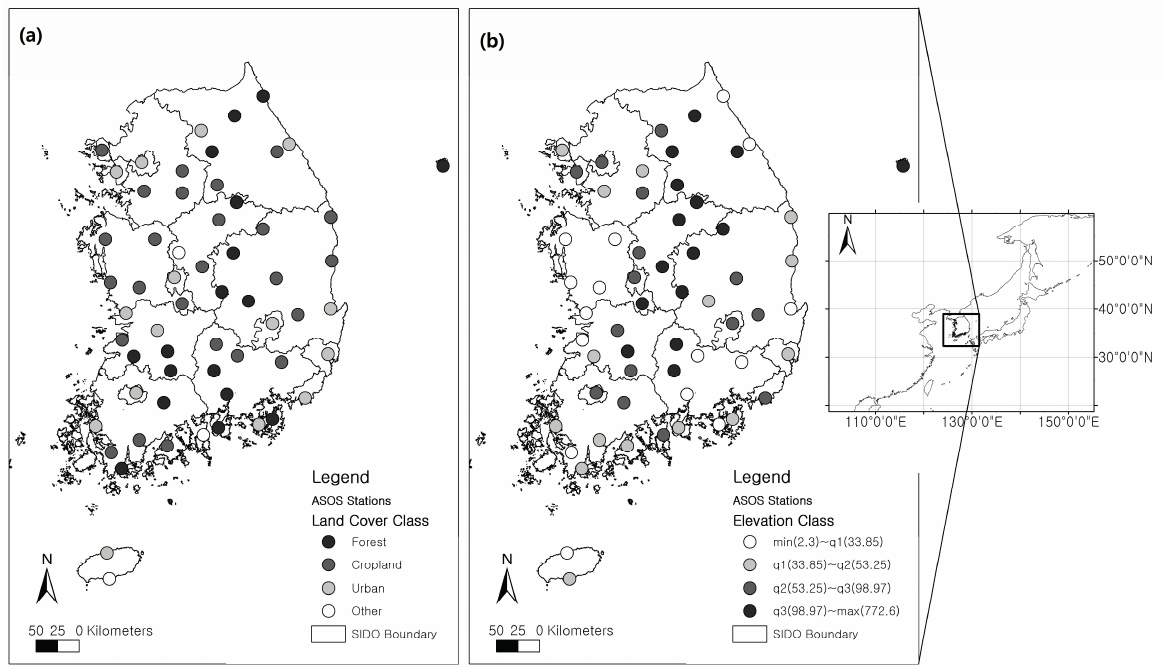
Figure 1. Sixty ASOS weather stations’ locations in South Korea; the stations were grouped into ( a ) four land cover classes; and ( b ) four elevation